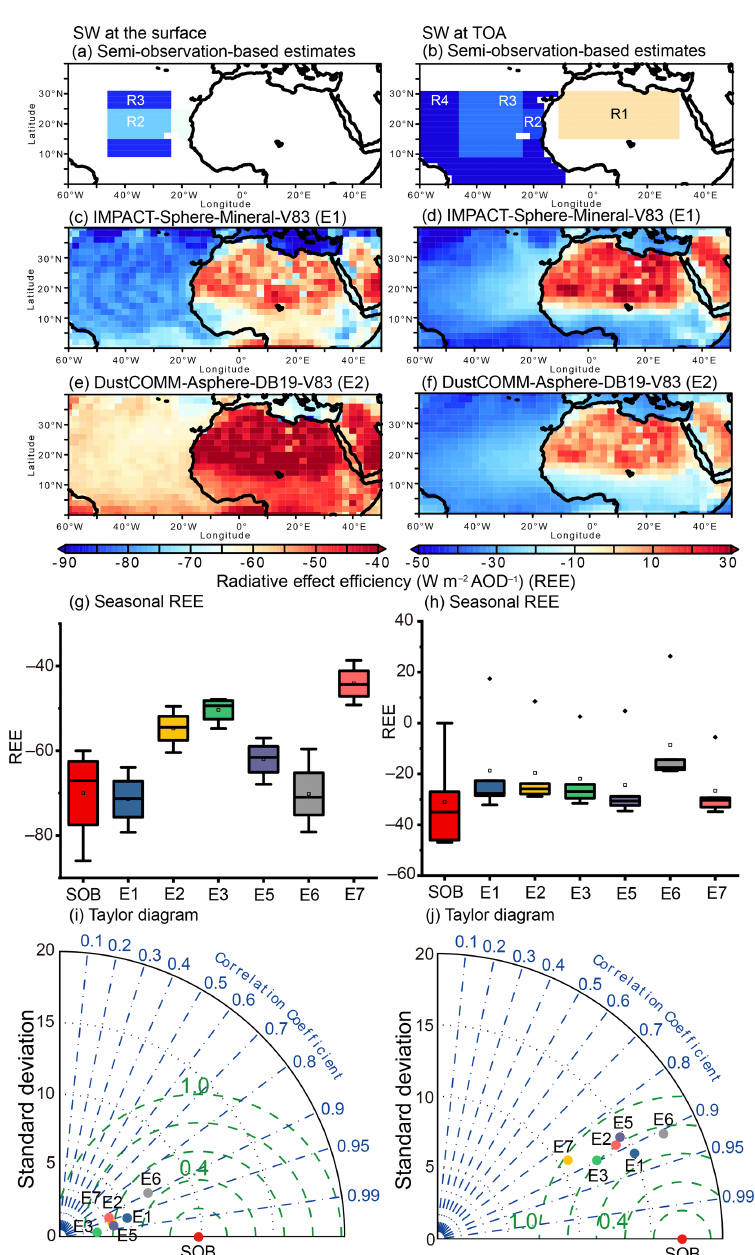
Figure 4. Dust clear-sky SW radiative effect efficiency (Wm − 2 DAOD − 1 ). Semi-observationally based data at (a) the surface and (b) TOA were based on satellite observations (Yang et al., 2009; Li et al., 2004; Song et al., 2018; Christopher and Jones, 2007). The model results are shown for (c, d) IMPACT-Sphere-Mineral-V83 (E1) and (e, f) DustCOMM-Asphere-DB19-V83 (E2) simulations at the surface and TOA, respectively. Comparison of seasonally averaged SW radiative effect efficiency for semi-observationally based (SOB) data and the different experiments at (g) the surface and (h) TOA. The square symbol represents the mean. The solid line within the box shows the median. The boundaries of the box mark the 25th and 75th percentiles. The whiskers above and below the box indicate the 1.5 × interquartile range, and the points indicate the outliers. Taylor diagram summarizing the statistics of the comparison against the seasonally averaged regional SW radiative effect efficiency for the different experiments at (i) the surface and (j) TOA. The horizontal axis shows the standard deviation of the data set or model prediction, the curved axis shows the correlation, and the green dashed lines denote the root-mean-squared errors between the semi-observationally based data and the model predictions. As such, the distance between the semi-observationally based data and the model predictions is a measure of the model’s ability to reproduce the spatiotemporal variability in the semi-observationally based data. The regionally averaged values are listed in Tables S3 and S4 at the surface and TOA,